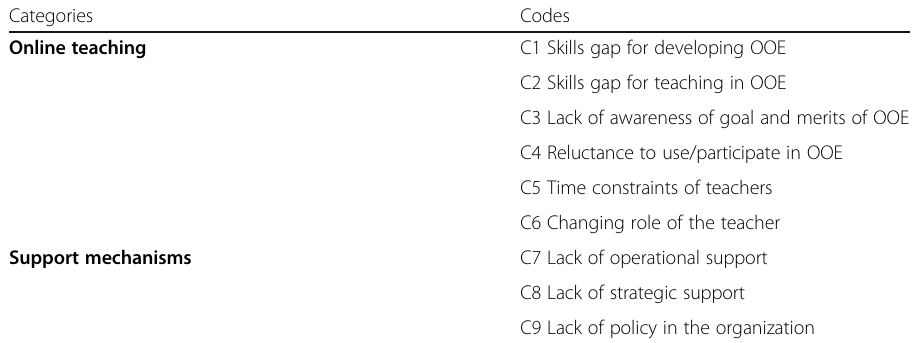
Table 3 Thematic coding scheme